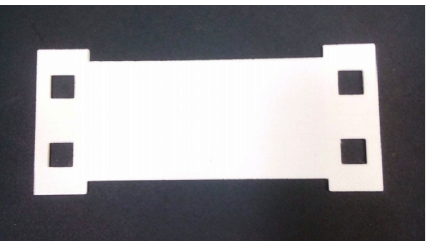
Figure 7: Specimen for experimental modal analysis (Case 1).